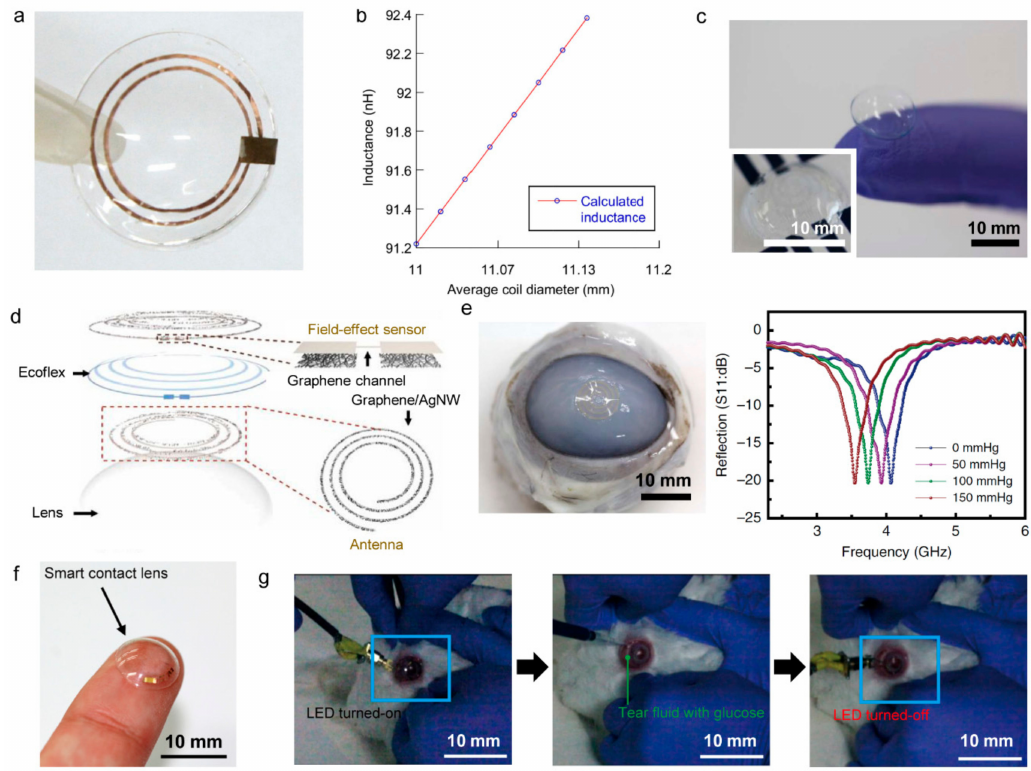
Figure 7. Smart contact lenses. ( a ) The contact lens sensor with sensing elements embedded in a